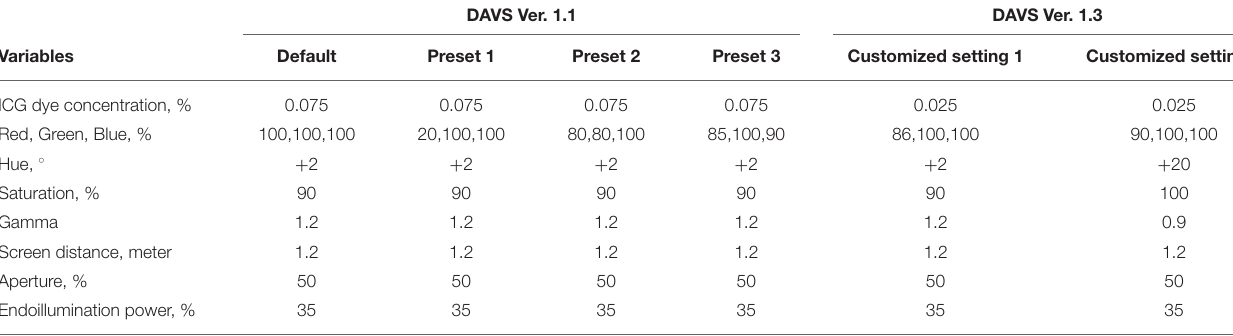
TABLE 1 | Concentrations of indocyanine green dye and parameters for digitally assisted vitreoretinal surgery